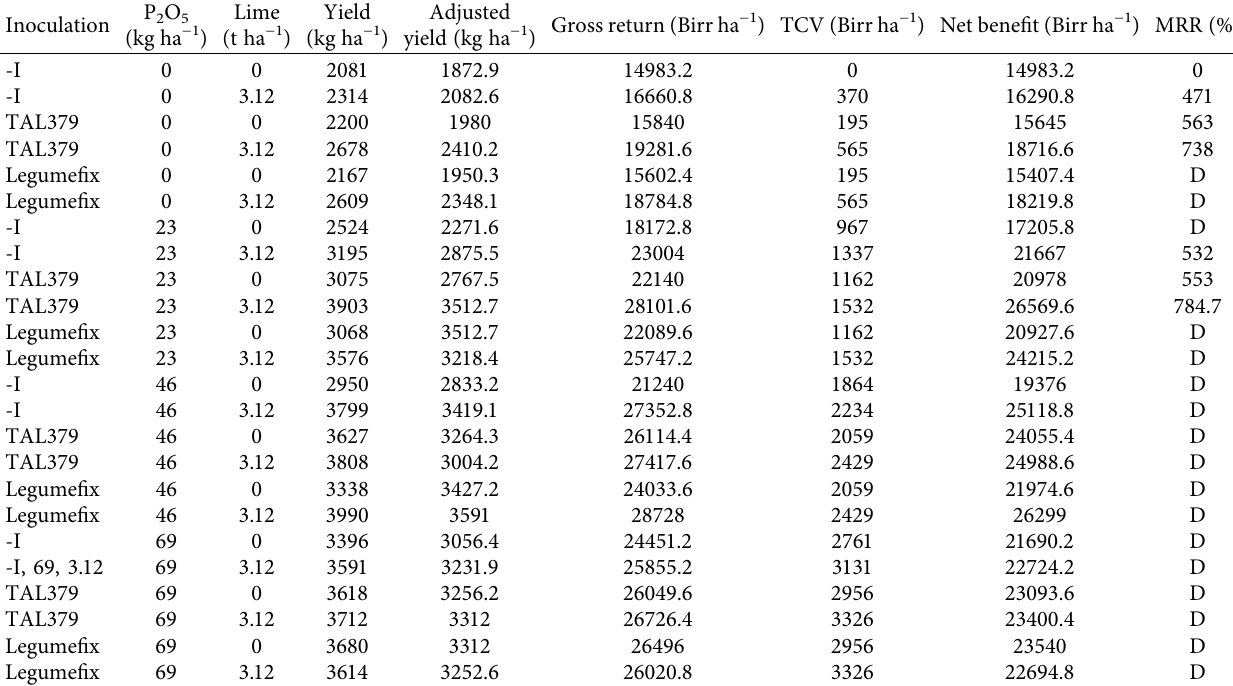
Table 5: Partial budget analysis of the effects of Bradyrhizobium strains, phosphorus, and lime rates on soybean. Inoculation